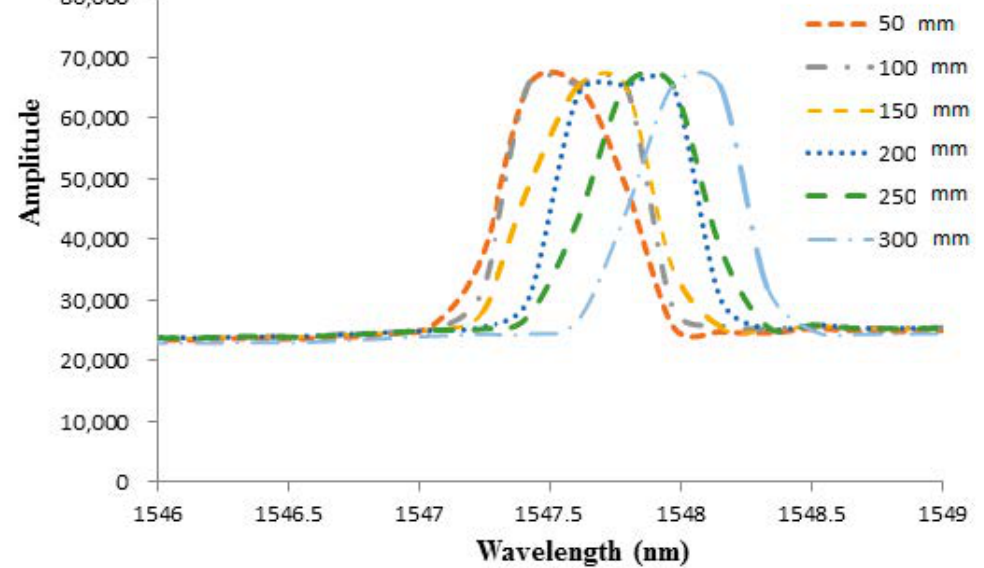
Figure 6. Optical spectra of Bragg wavelength reflected from the FBG sensor under various water levels with diaphragm thickness of 0.5 mm.